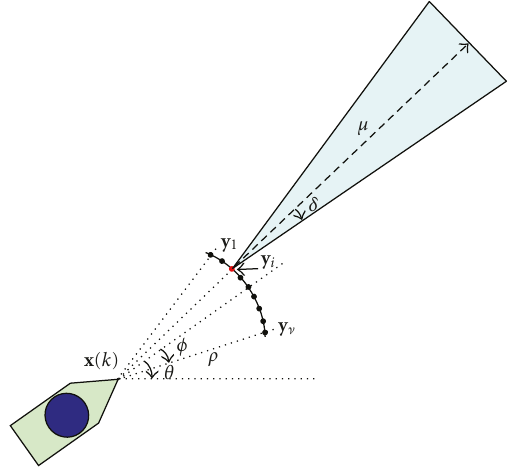
Figure 11: Triangular region used for the J r ( y ) cost function.